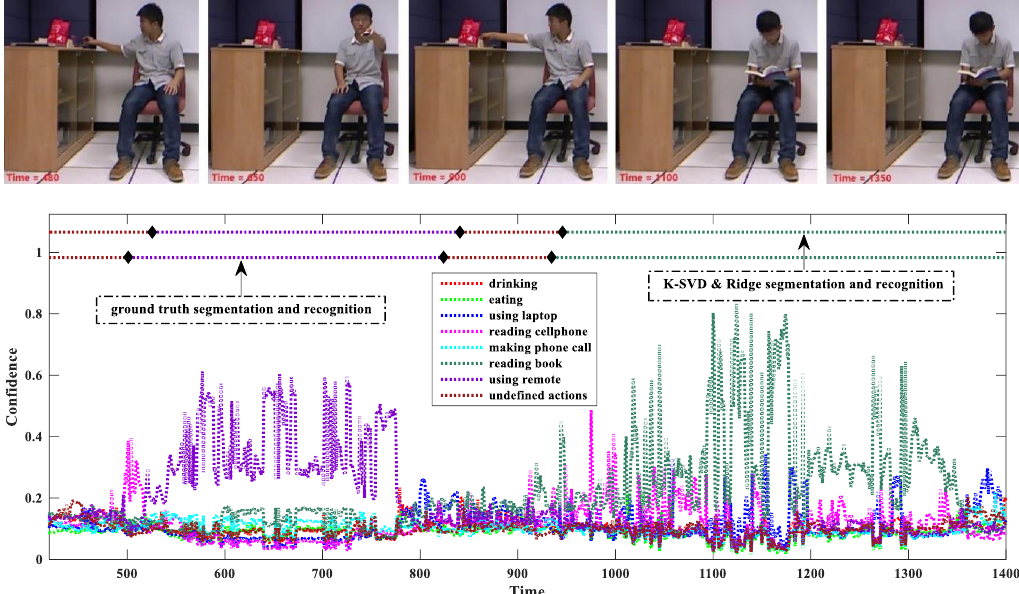
Figure 7. Confidence variation and temporal smoothness. Each frame is predicted by eight confidences associated with the seven meaningful actions and undefined actions. The black diamonds indicate the cut points between consecutive actions. The colors of the dashed lines across the diamonds indicate the action classes. The ground truth cut points are 500, 823, and 934. The detection cut points of the K-SVD & Ridge are 525, 840, and 945. The upper five images show the five key poses with the temporal instances 480, 650, 900, 1100, and 1350. The RGB channel and depth channel of the Kinect are not strictly synchronized, but this slight misalignment can be neglected for observation.